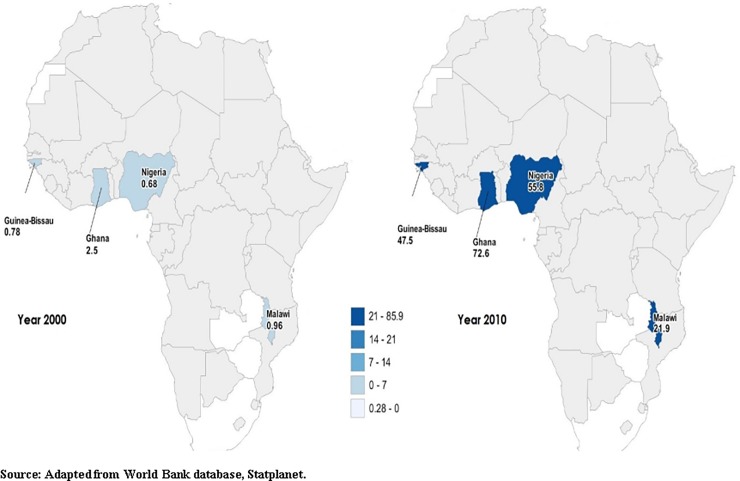
Trend in the prevalence of fixed and mobile phone subscription in the study countries.